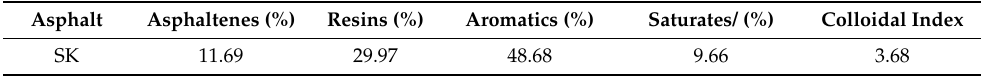
Table 2. The four components of base asphalt.